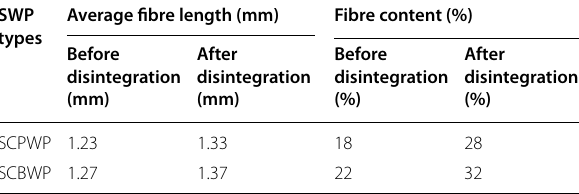
Table 2 SWP fibre properties (Borysiuk et al.,